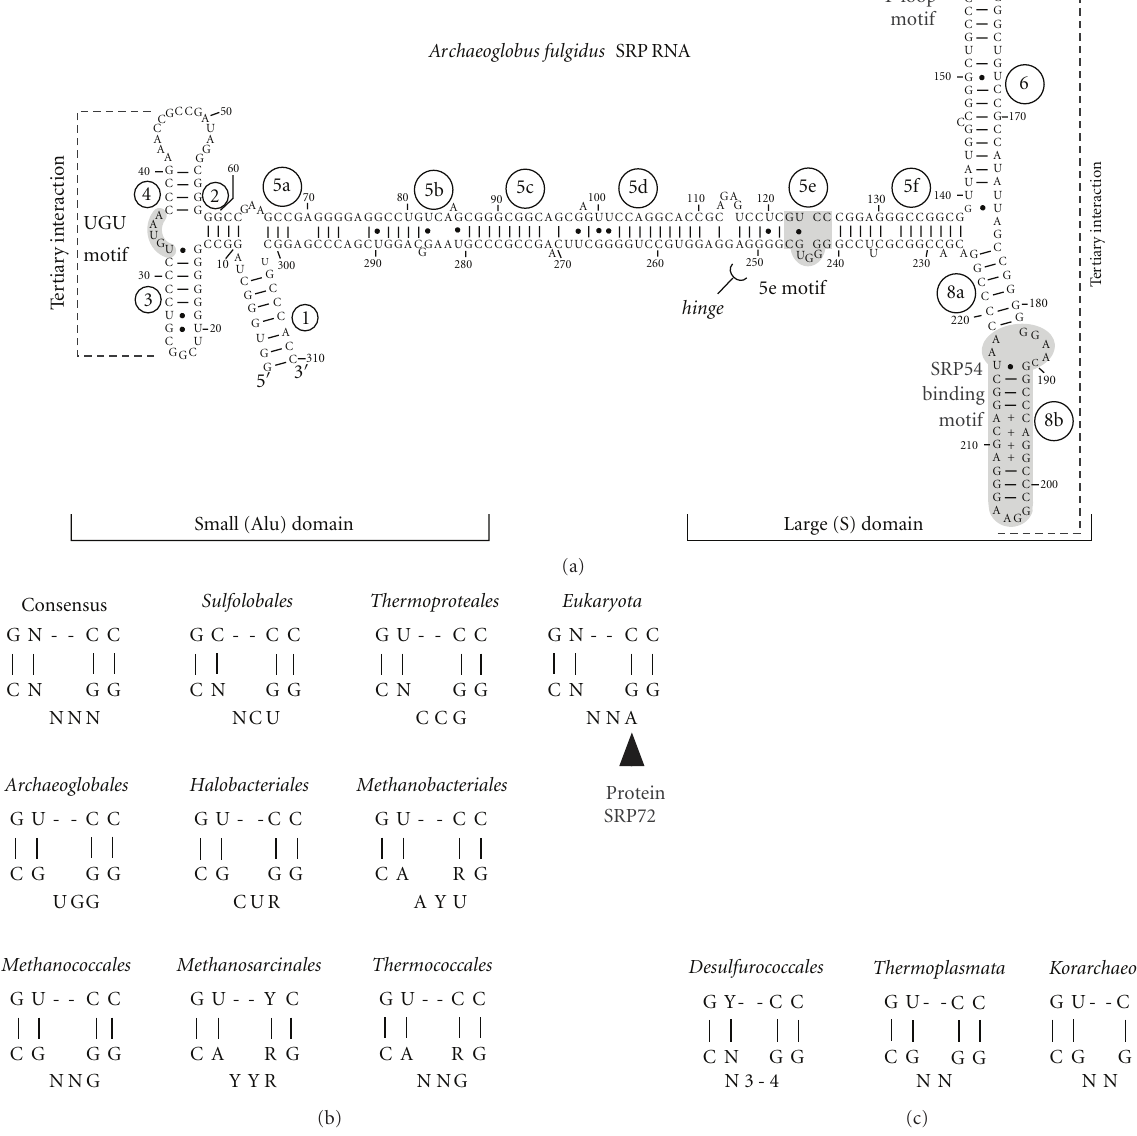
Figure 2: Archaea SRP RNA features. (a) Secondary structure of Archaeoglobus fulgidus SRP RNA. (b) Consensus-matching 5e motifs sorted by their taxonomic membership. (c) Mismatching 5e motifs. Helices are numbered from 1 to 8 and helical sections are labeled with letters a to f [33]. For example, helix 1 is composed of residues one to seven which are base paired with residues 303 to 310; helix 2 consists of residues at positions ten to 13 base paired with the residues at positions 59 to 62. The extended helix 5 contains six helical sections, 5a to 5f. Helix 7 is lacking in the SRP RNAs of the archaea. The 5 (cid:2) - and 3 (cid:2) -ends are shown, and residues are labeled in ten-residue increments. Base pairs were determined by comparative sequence analysis [32] and by considering high-resolution data (Table 1). The approximate extents of the large (S) and the small (Alu) domains are indicated. Shown in dark gray are the UGUNR motif (labeled UGU) in the small domain, the 5e motif within helical section 5e at the indicated hinge [34], the GNAR apical tetraloop of helix 6 and the SRP54 binding motif of helix 8 in the large domain. Dashed lines suggest tertiary interactions.